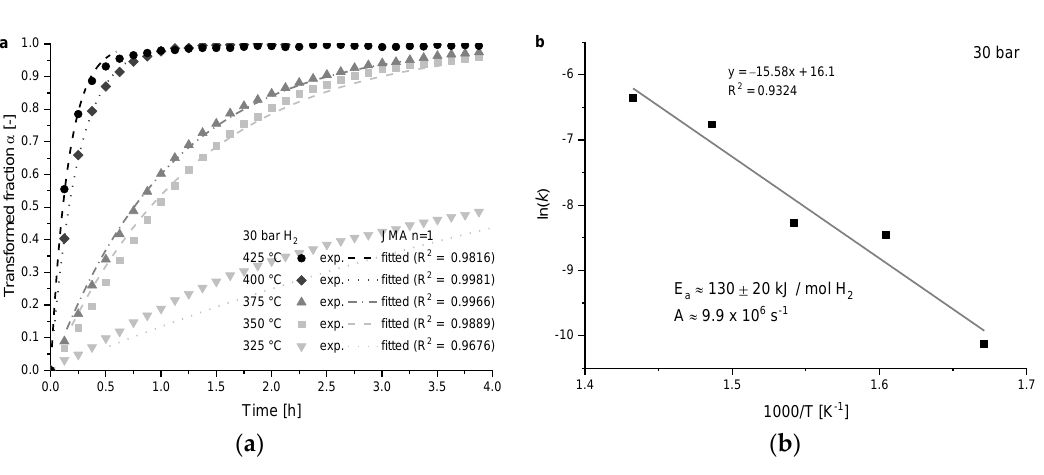
Figure 4. ( a ) Quantity of hydrogen desorbed at 400 °C and 2 bar H 2 upon cycling, for different amounts of compacted/uncompacted samples after absorption at 350 °C and 50 bar H 2 ; ( b ) Time for absorption and desorption of 80% transformed fraction upon cycling for the 500 mg sample.